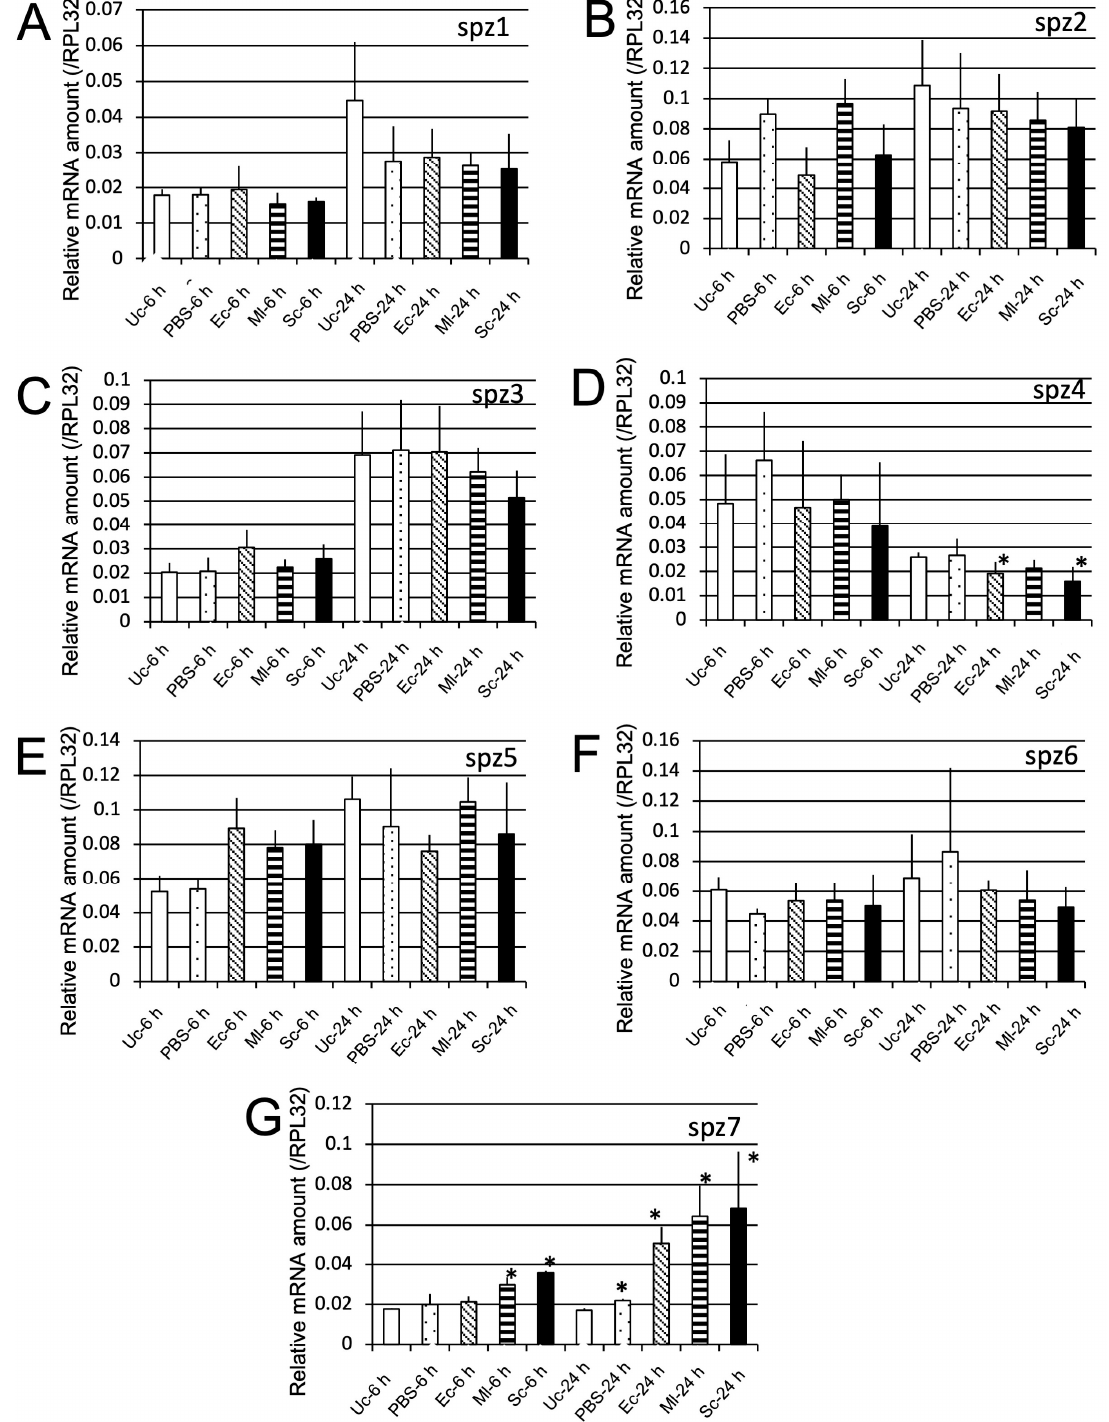
Figure 9. mRNA levels of spzl1 ( A ), spz2 ( B ), spz3 ( C ), spz4 ( D ), spz5 ( E ), spz6 ( F ), and spz7 ( G ) after challenge with three microbial species. The mRNA levels of the genes are shown as relative values to RPL32 mRNA levels in the same samples. Experiments with three animals were independently repeated three times, and each column represents the mean ± S.D. Asterisks indicate p < 0.05 compared to Uc samples, according to Student’s t -test.